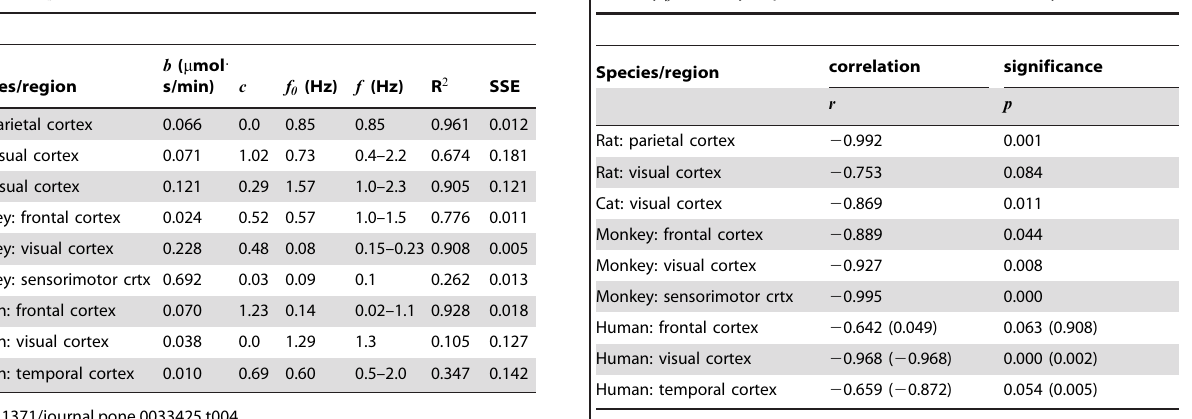
Table 4. Best fits to the data for parameters in the relation CMR vs. r across mammals. s